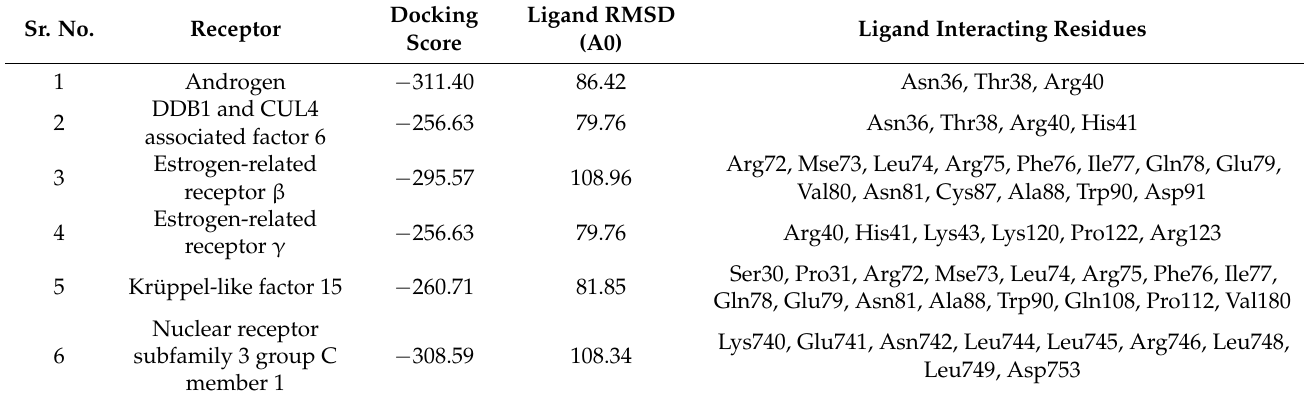
Table 3. Molecular docking results of ligand (FNDC5 or Irisin) binding affinity with different receptors. Sr. No.